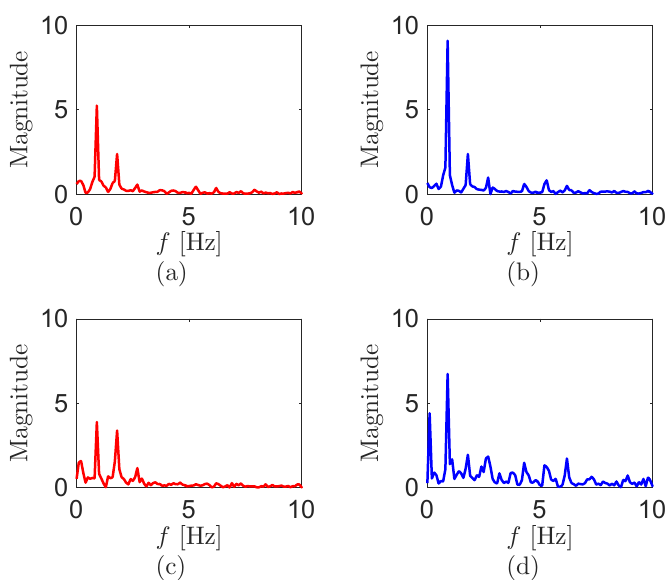
Figure 4. FFT magnitude spectra of the signal processed values from the sensor outputs during walking at the ( a ) left hip; ( b ) right hip; ( c ) left knee; and ( d ) right knee. The test walking velocity is